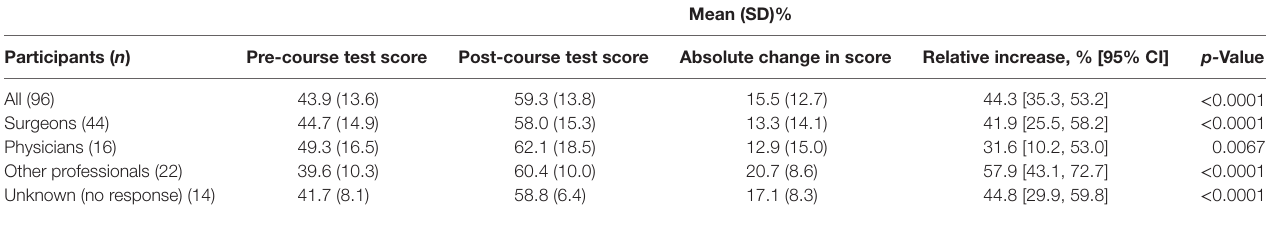
TaBle 2 | Change in scores from pre-course to post-course questionnaire by profession.